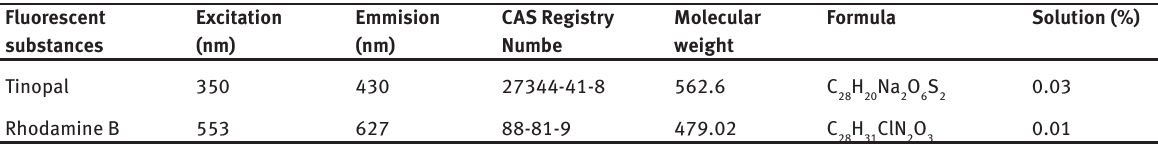
Table 2: Applied fluorescent substances and their concentration. Fluorescent